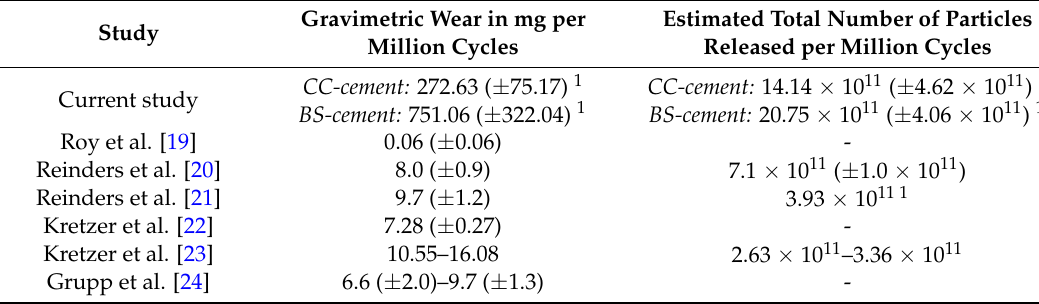
Wear behavior obtained on cement in the current study spacers in comparison to published studies on conventional polyethylene in total knee replacements. Values are presented as means ± standard